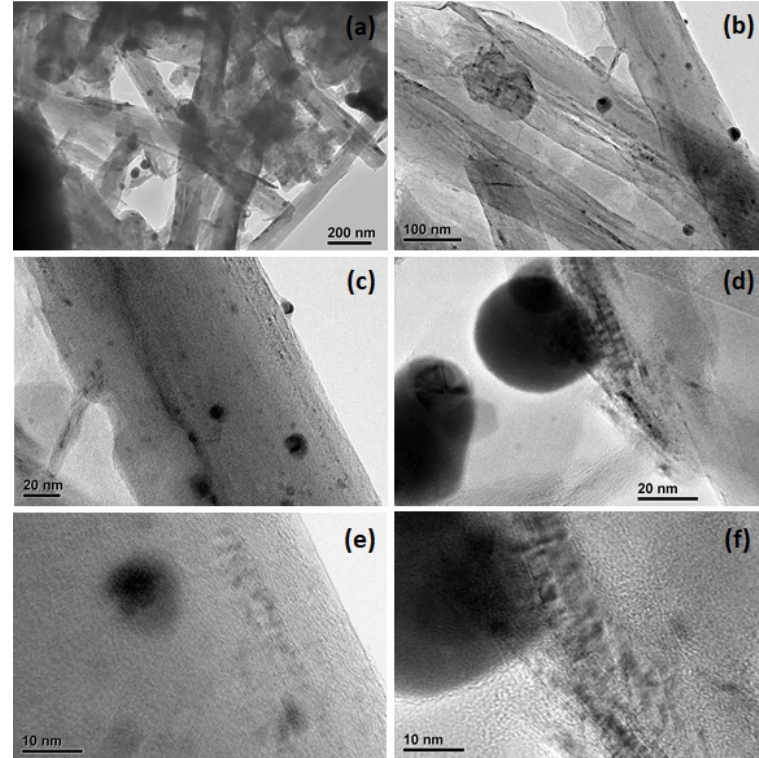
Figure 3. ( a–f ) TEM images of CNTs ‐ Ag 2 S.